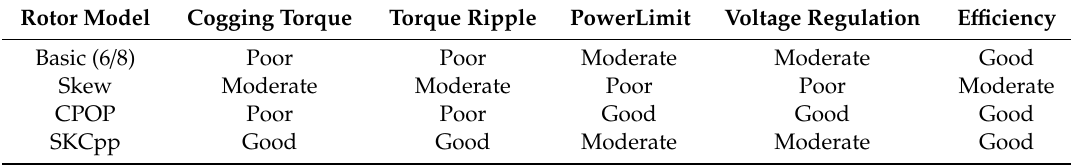
Table 7. Comparison table of all the rotor designs of 6 / 8 NRE-PM FRM Generators. Rotor Model Cogging Torque Torque Ripple PowerLimit